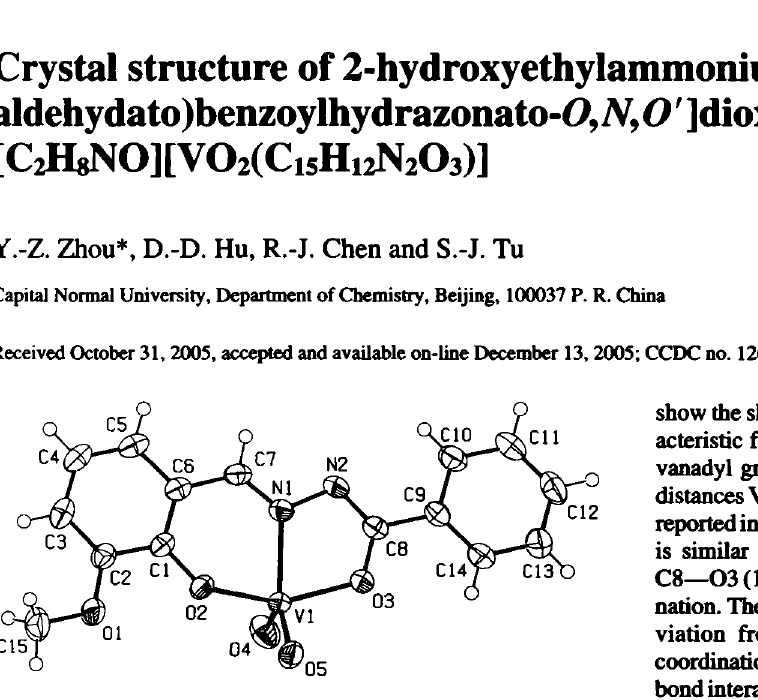
Table 1. Data collection and handling.